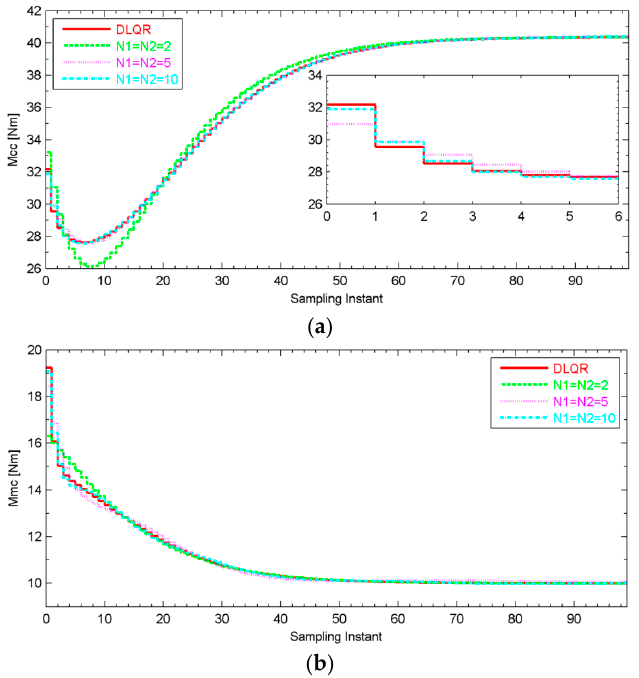
Figure 7. Difference between the optimum trajectories in the case of a 1 = a 2 = 0.9. The sampling interval is ten milliseconds. ( a ) Difference between the optimum trajectories of the clutch torque command M cc ; ( b ) Difference between the optimum trajectories of the motor output torque command M mc